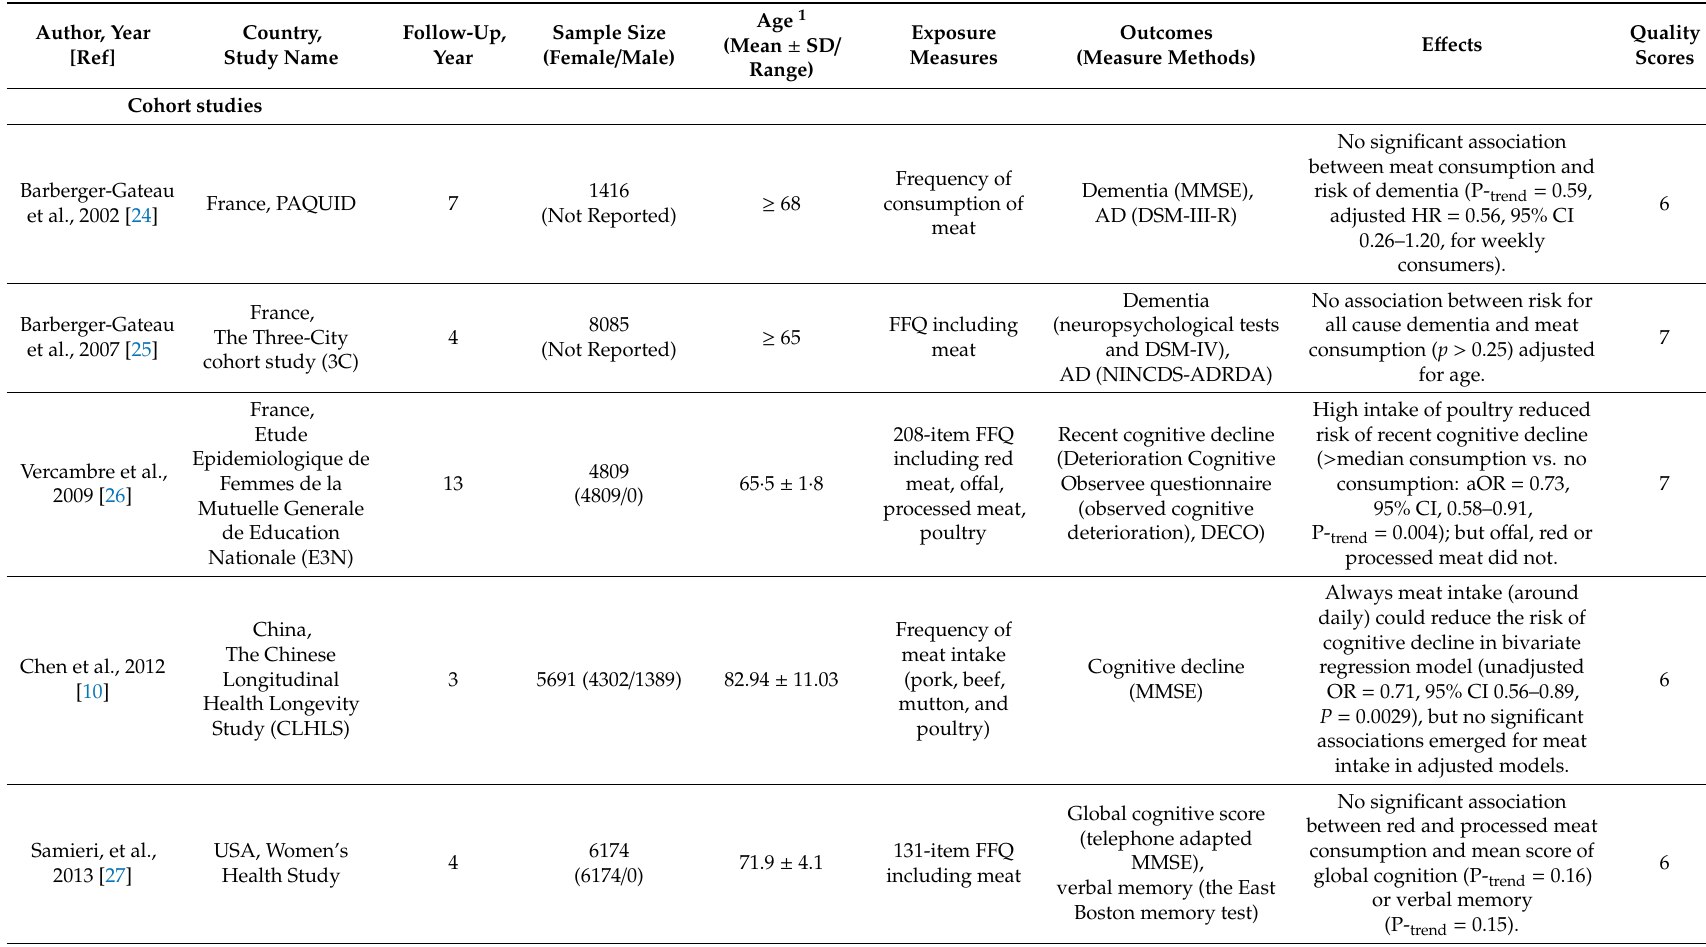
Table 1. Characteristics of 29 studies included in the systematic review on associations between meat consumption, cognitive function, and